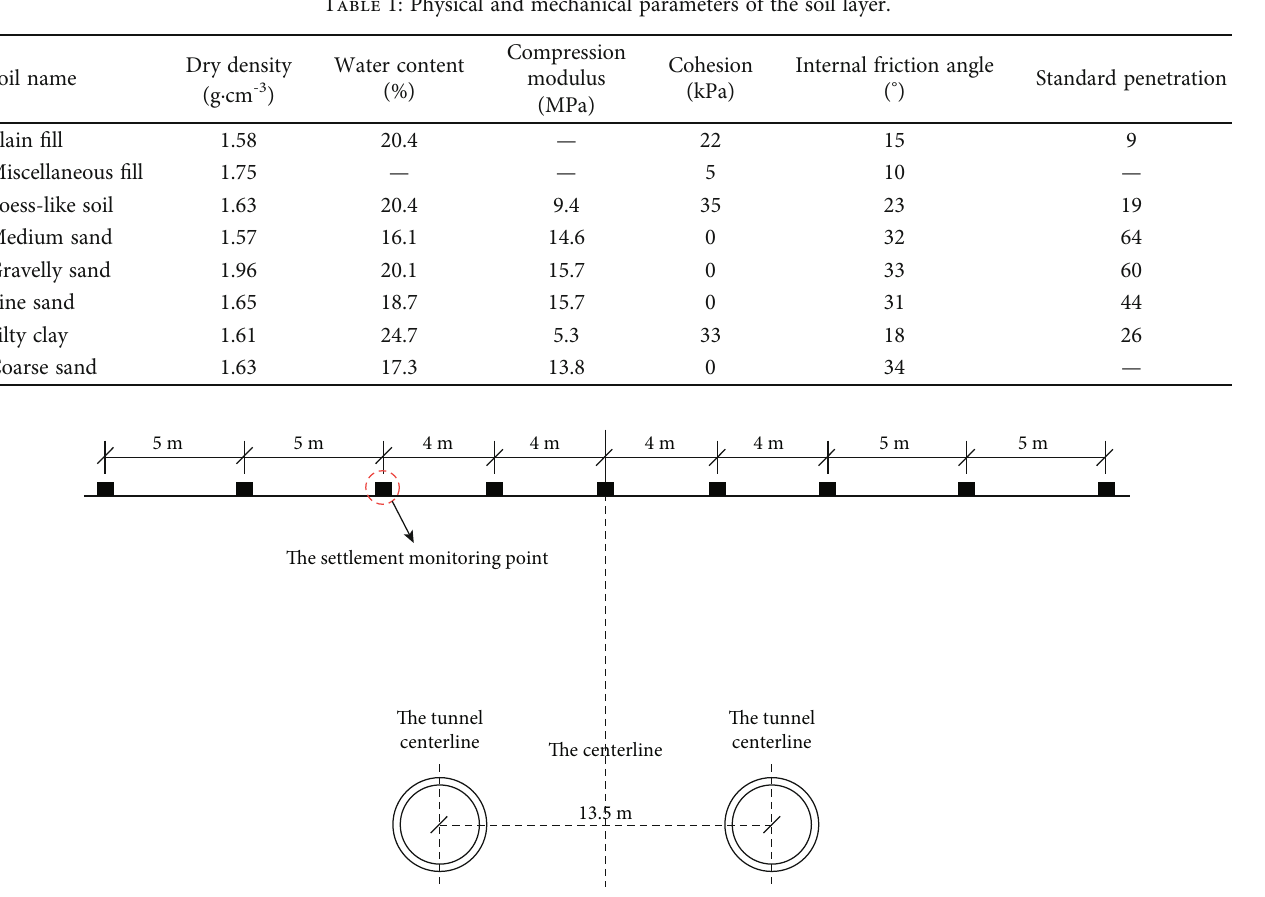
Figure 3: Layout of the surface settlement monitoring points in the test